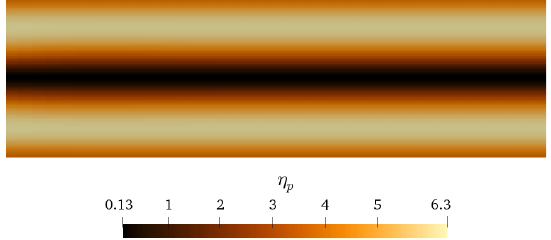
Figure 10. Contour plot of the particle viscosity profile for the 2D channel flow with U = 1.5133. Parameter values are: S = 10 − 1 , F = 10, c 3 = − 23.5, c 7 = − 0.47, c 8 = 10 − 4 , c 9 = 0, η S = 1, f ( φ ) = 1.0957, k 1 = − 10 3 , k 4 = −